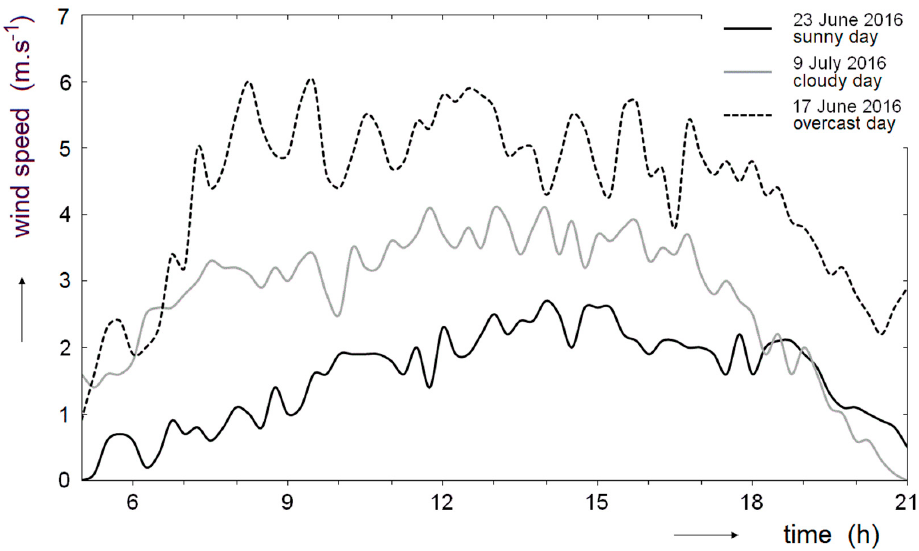
Figure 6. Dependence of the wind speed relative to time during the three selected days in 2016.